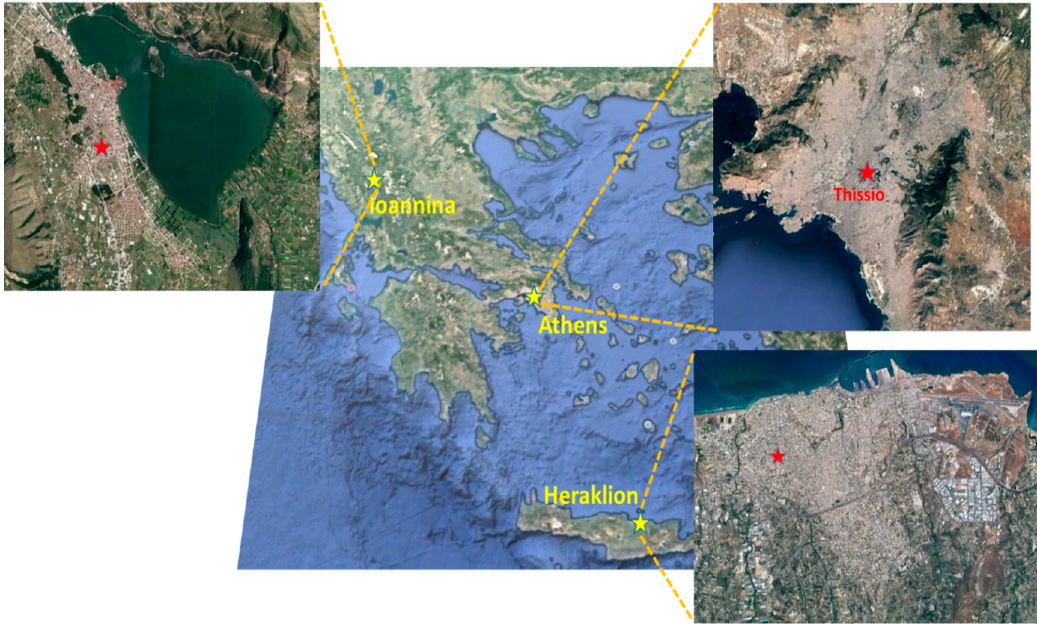
Figure 1. Map of the sampling sites (red stars) in Ioannina, Athens (Thissio), and Heraklion.